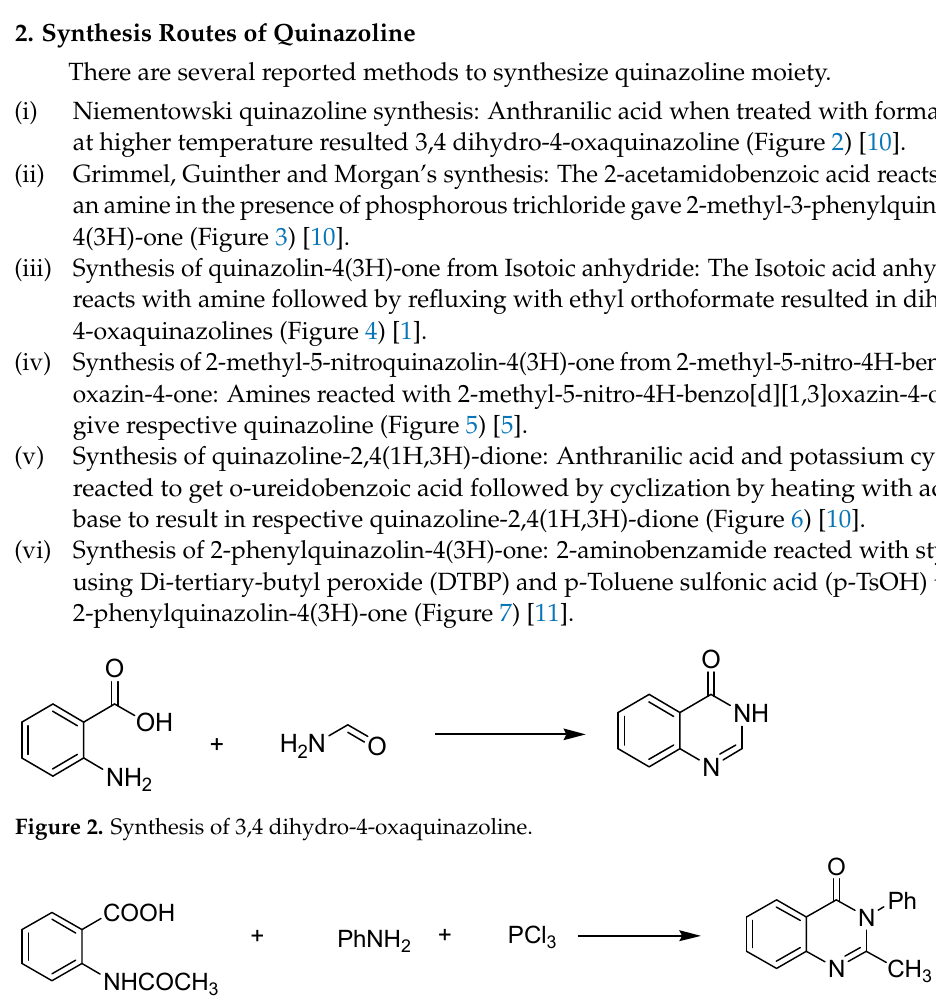
Figure 3. Synthesis of 2-methyl-3-phenylquinazolin-4(3H)-one.